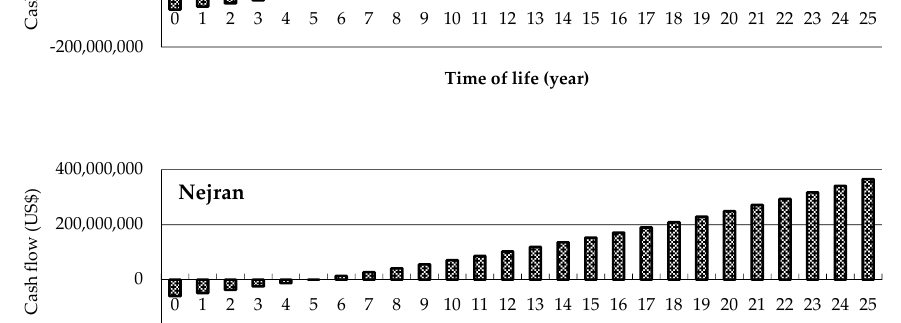
Figure 14. Simple and equity payback for all sites.